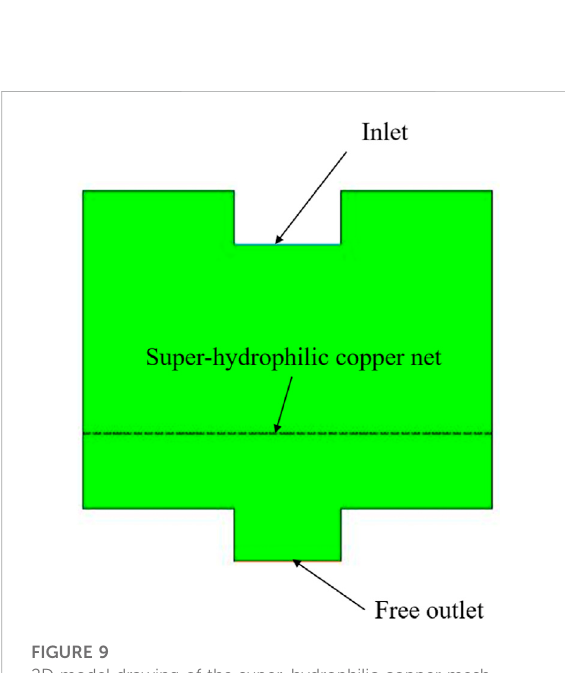
FIGURE 9 2D model drawing of the super-hydrophilic copper